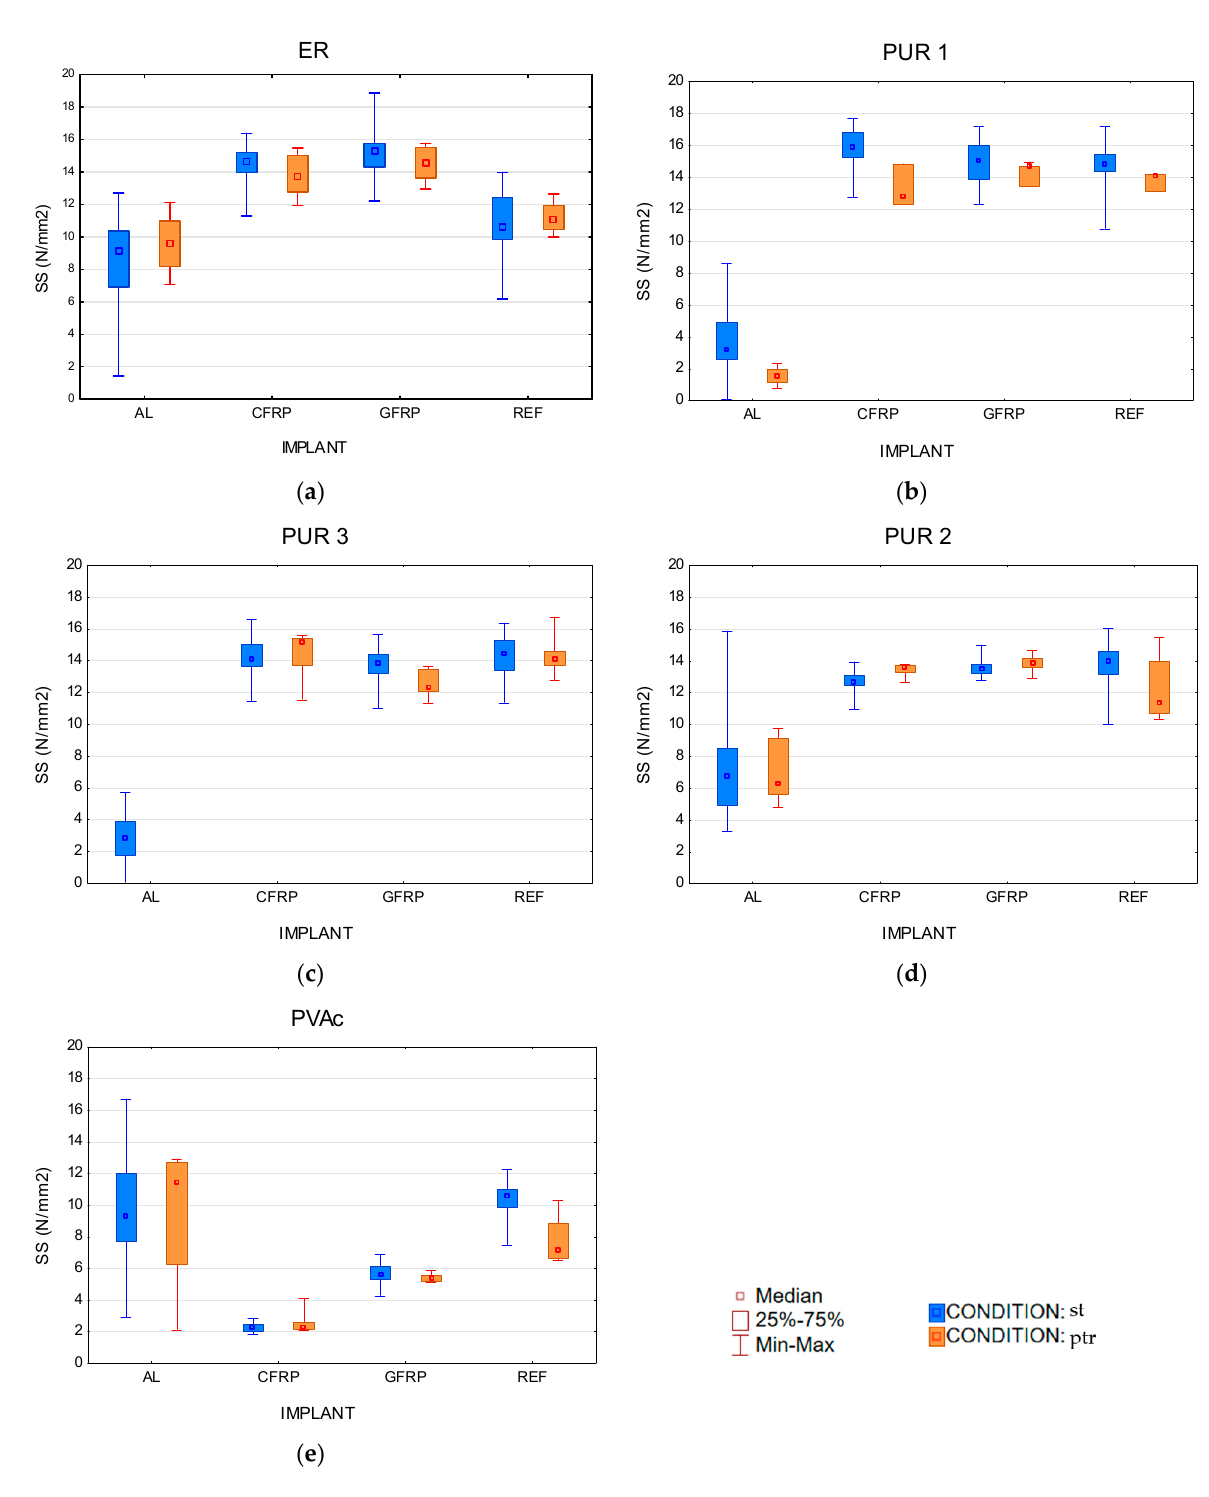
Figure 6. Box plot by implant group of shear strength (SS) for st—standard conditioned samples and ptr—climatically pre-treated samples. ( a ) 2-k epoxy resin, ( b ) thermoplastic 1-k polyurethane adhesive, ( c ) structural 1-k polyurethane adhesive, ( d ) structural 2-k polyurethane adhesive, ( e ) 1-k polyvinyl acetate.